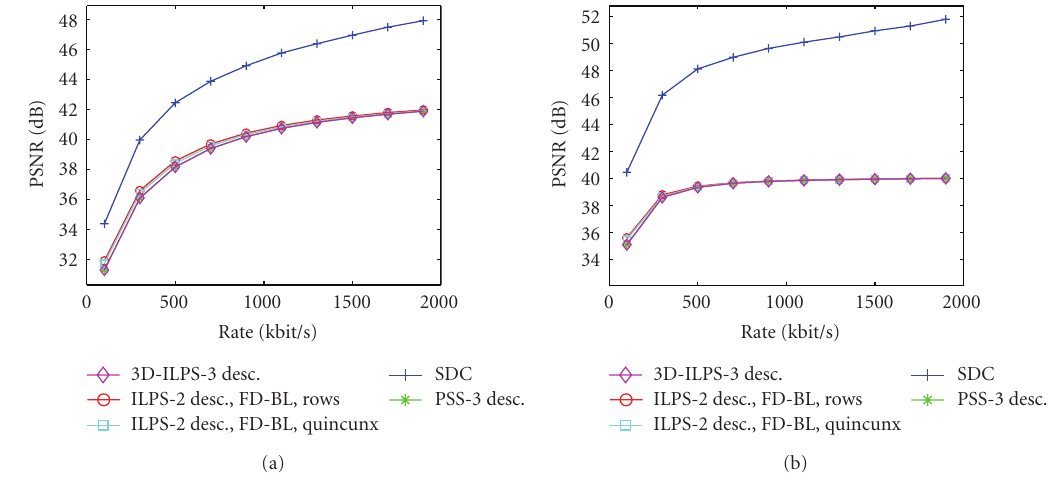
Figure 8: Performance of color view, three subsequences received. (a) Breakdance. (b) Ballet.